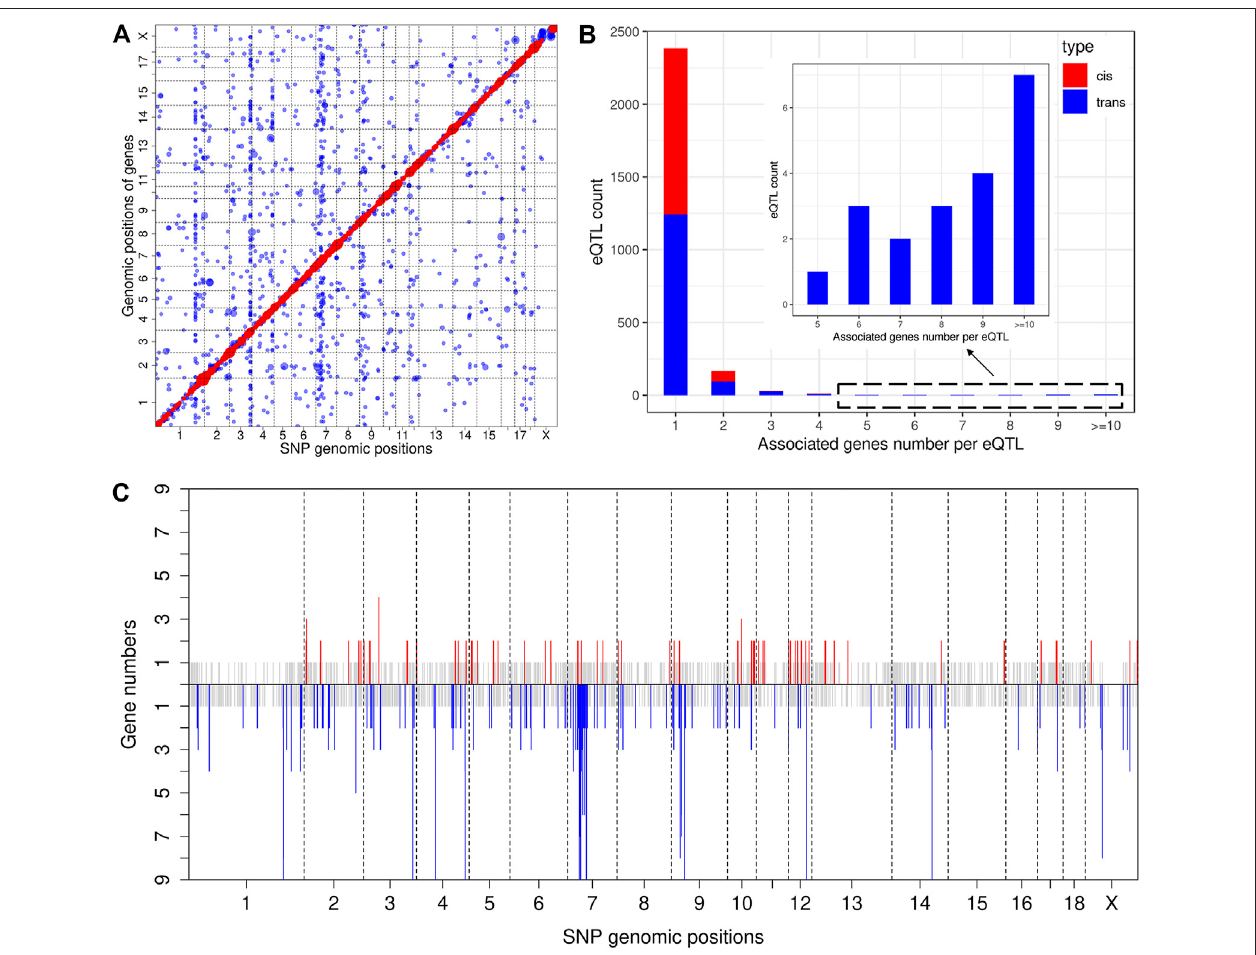
FIGURE 3 | Genome-wide eQTL analysis. (A) Scatter plot of all eQTL. Each dot represents a SNP-gene pair, with the vertical direction linking to the SNP and the horizontaldirectionlinkingtothegene.Theredandbluedotsrepresent cis -eQTLand trans -eQTL,respectively.Thesizeofthedotrepresentsthedegreeofsigni fi cance. (B) Analysis of eQTL pleiotropy. The X-axis of the histogram represents different groups that were classi fi ed according to the associated gene numbers per eQTL, and the Y-axis represents the eQTL count for each group. cis -eQTLs and trans -eQTLs are distinguished by red and blue color. (C) Distribution of eQTL hotspots. The X-axis represents the chromosome distribution of eQTLs, the Y-axis indicates the count of genes associated with each eQTL. The upper part displays the cis -eQTL hotspot distribution, and if the count of associated genes is 1, it is shown in grey. If greater than 2, it is shown in red. The lower part displays the trans -eQTL hotspot distribution, and if the count of associated genes is 1, it is shown in grey. If greater than 2, it is shown in